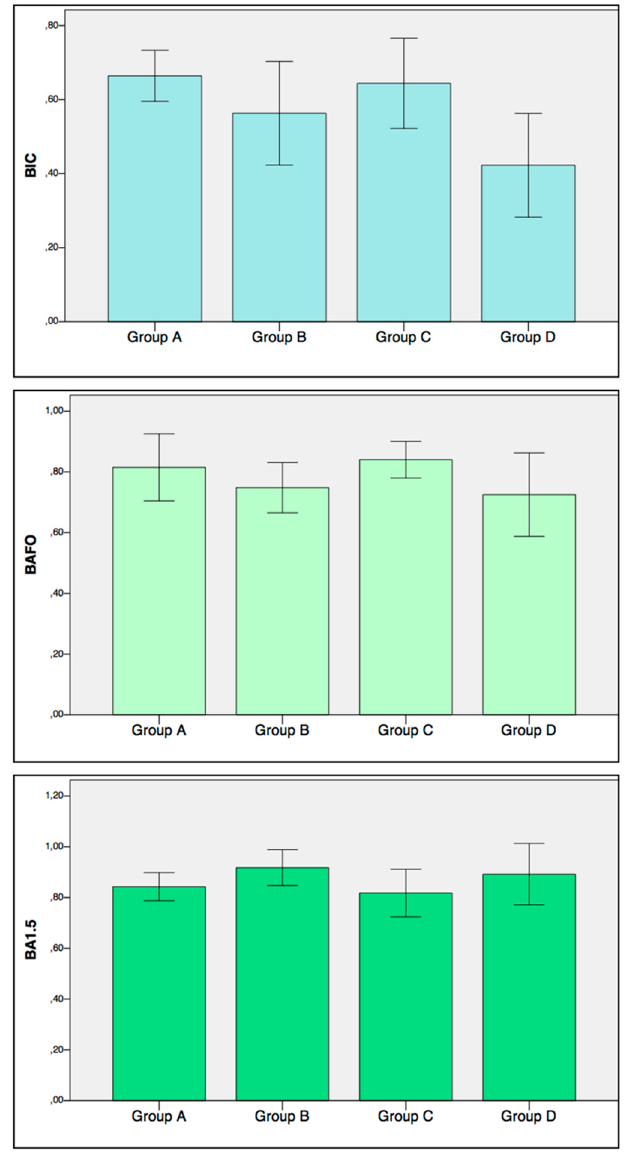
Figure 4. Bone to Implant Contact ( BIC ), Bone Area Fraction Occupancy ( BAFO ), and Bone Area Fraction Occupancy up to 1.5 mm ( BA1.5 ) results represented as mean values. Error bars represent the standard deviation.